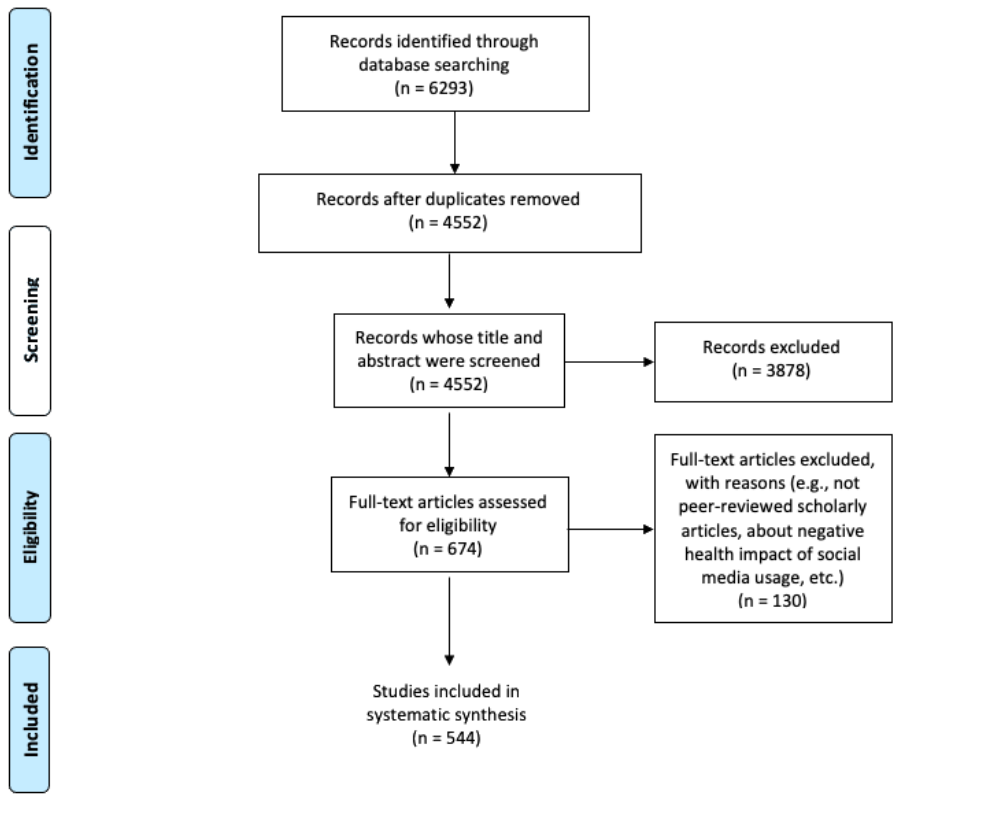
Figure 1. Article search and screening